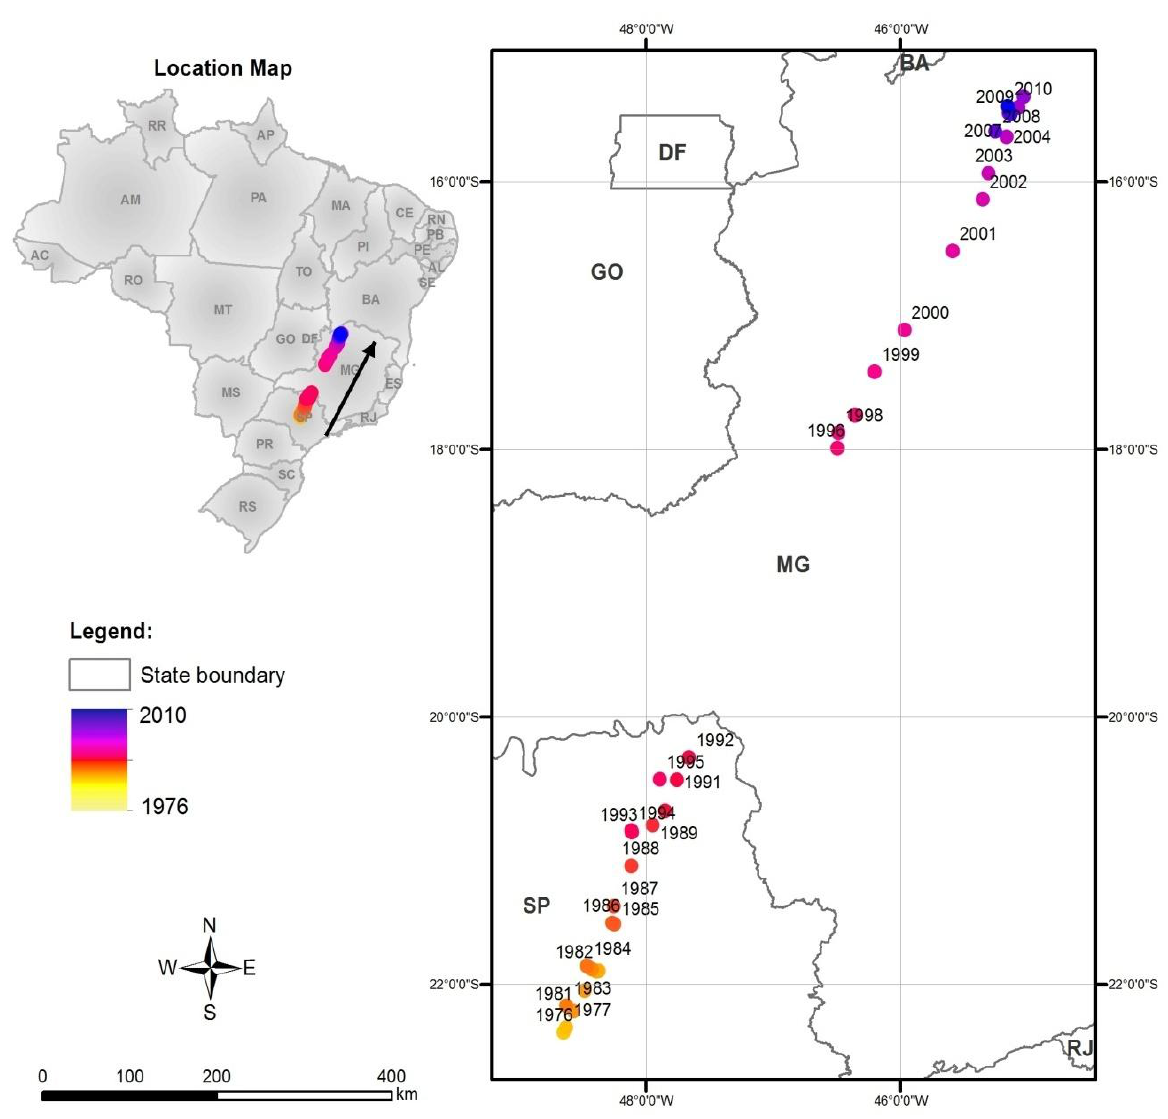
Figure 3. Spatial mid-point of average sheep production in Brazil from 1976 to